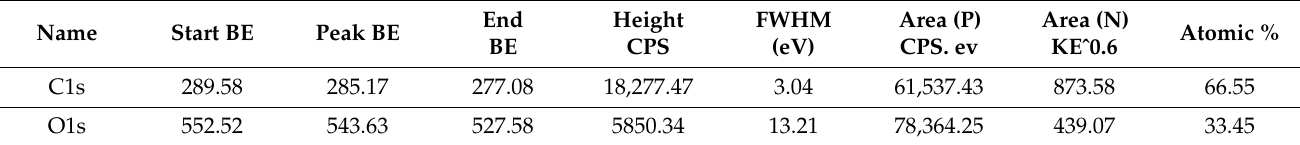
Table 3. Peak table of graphite-treated cotton fabrics.